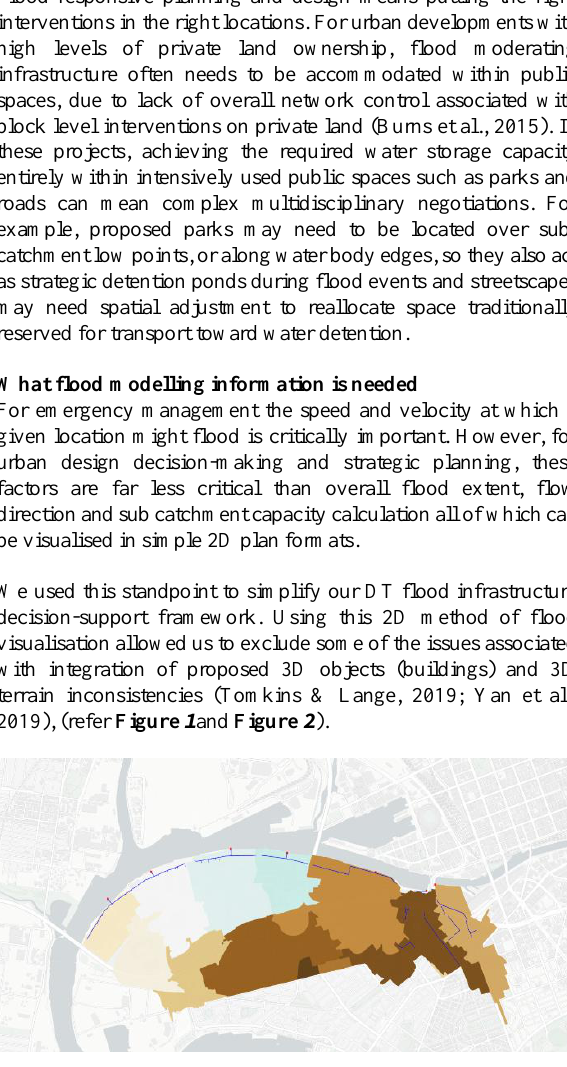
Figure 1: 2D visualisation of sub catchments within the study area